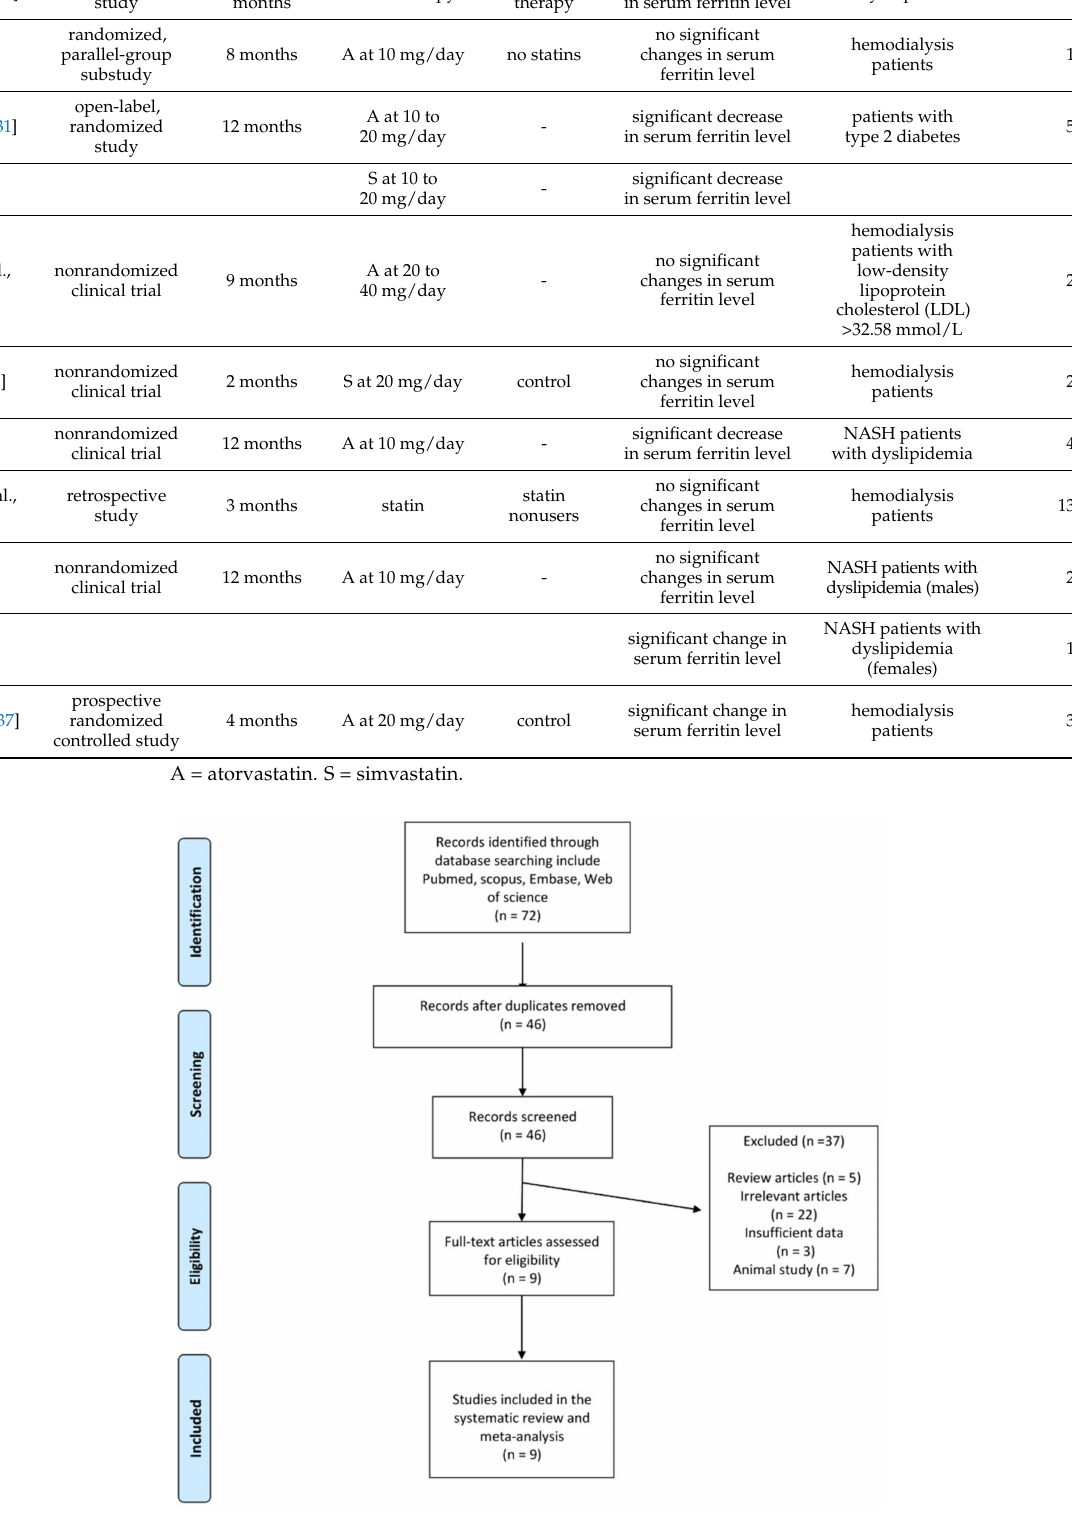
Figure 1. Flow chart of identified publications and those included into the